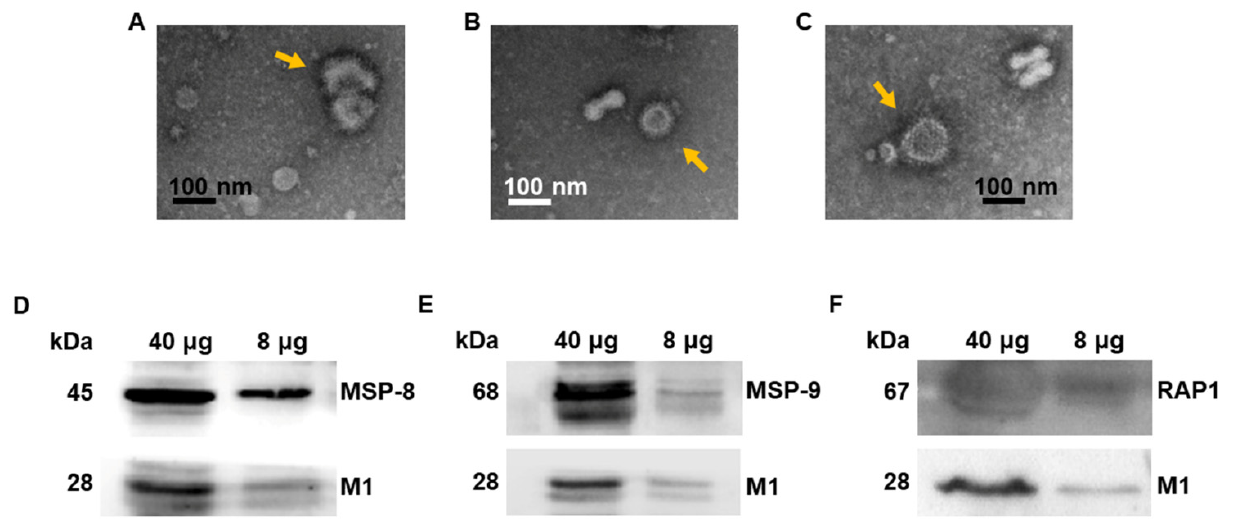
Figure 1. VLPs characterization. MSP-8 ( A ), MSP-9 ( B ) and RAP1 ( C ) VLP morphologies were visu- alized under TEM. MSP-8 ( D ), MSP-9 ( E ) and RAP1 ( F ) VLPs were loaded (8, 40 µg) for SDS-PAGE, and bands corresponding to each antigen were observed using either the polyclonal P. berghei anti- body or the monoclonal M1 antibody.